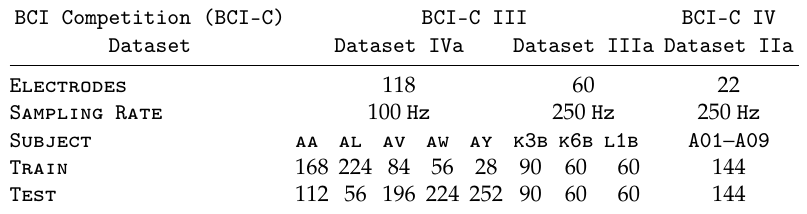
Table 1. Summary of Dataset IVa, Dataset IIIa and Dataset IIa from BCI competitions